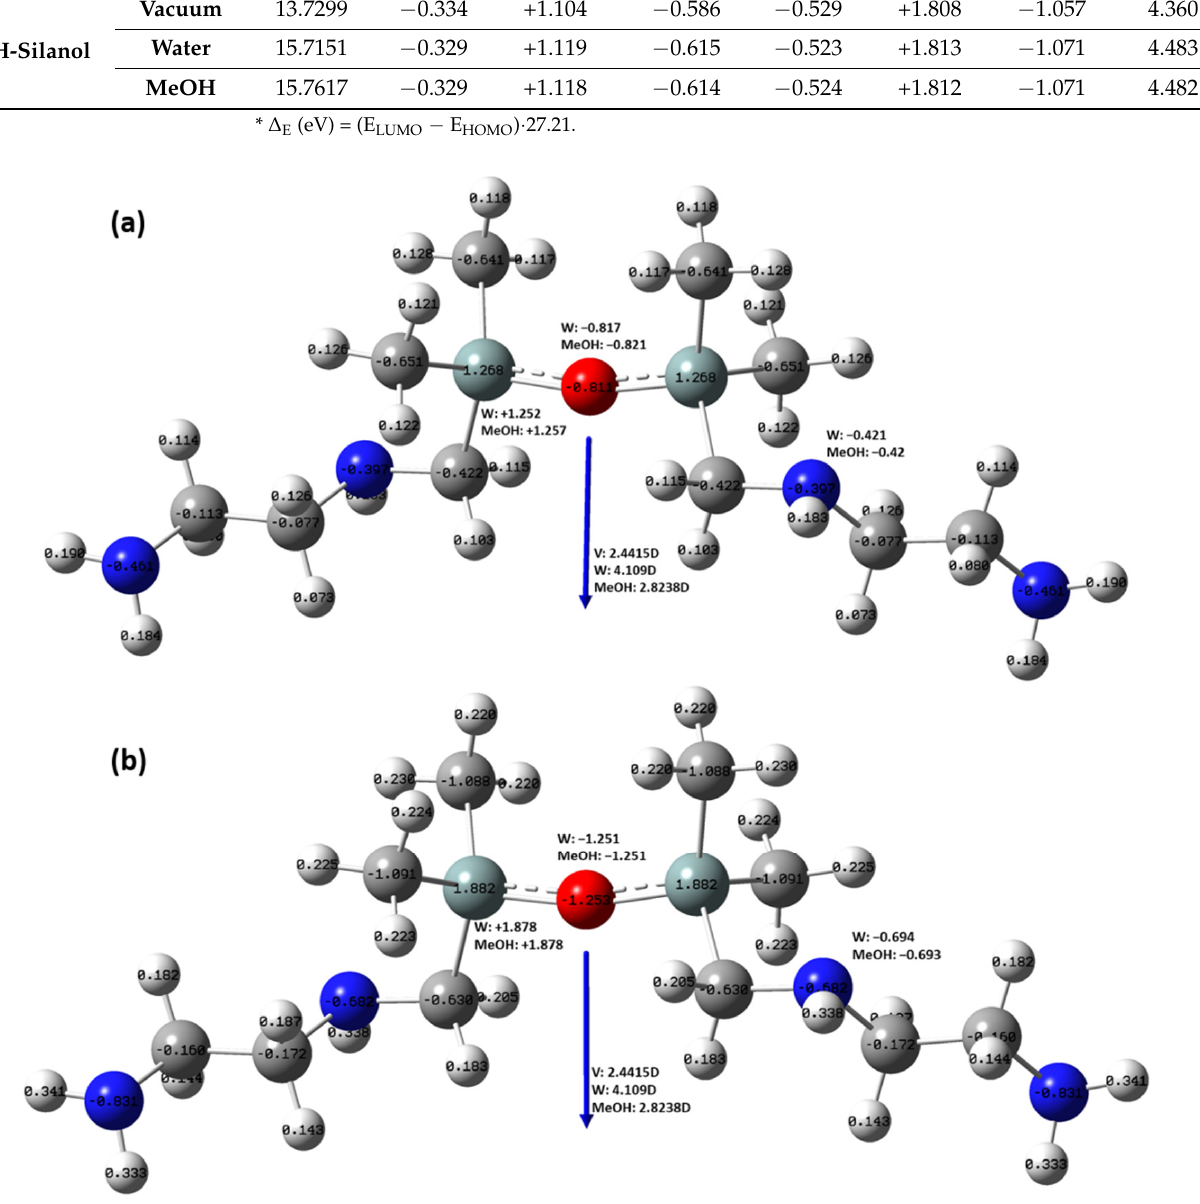
Figure 5. Partial charges for APTMDS: ( a ) Mulliken, ( b ) NPA from NBO; implicit solvents: W— water, MeOH—methanol, V—vacuum.